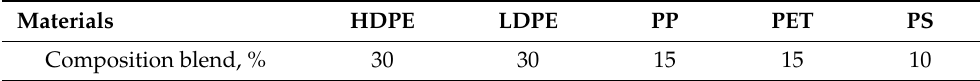
Table 2. Composition of the mixture.